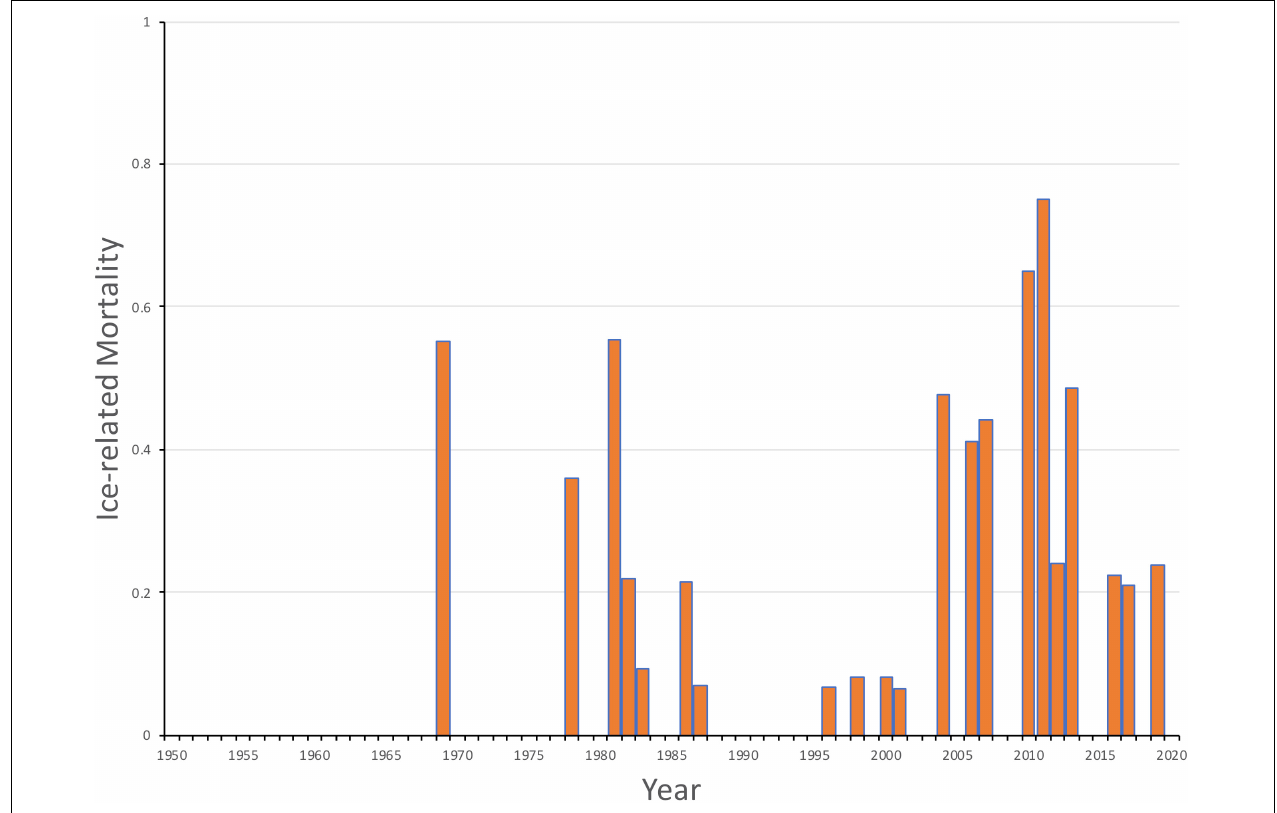
FIGURE 9 | Estimated ice-related mortality of NWA harp seal young of the year (1952-2019) based upon ice conditions in the Gulf of St. Lawrence and off Newfoundland (Hammill et al.,